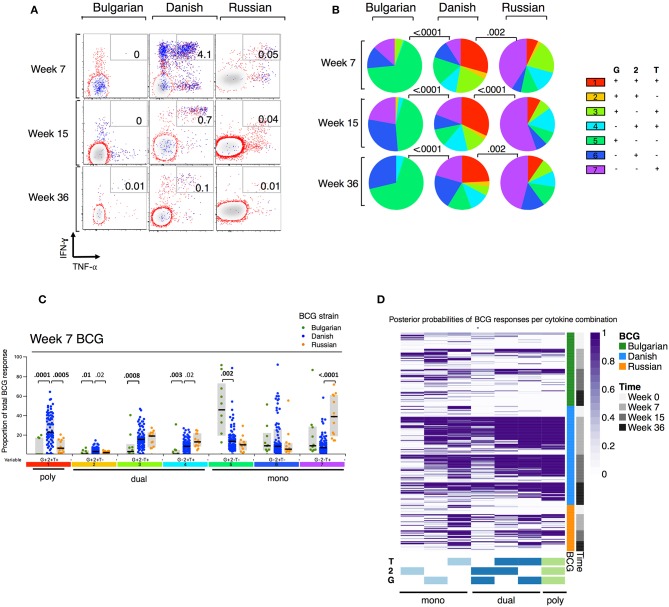
Polyfunction of mycobacterial-specific CD4+ T cell cytokine responses differ between strains. (A) Representative flow cytometry plots showing mycobacterial-specific cytokine expression by CD4+ cells stratified by BCG immunizing strain. Axes show IFN-γ vs. TNF-α expression with IL-2+ cells overlaid and represented by blue dots. Numbers indicate frequency of polyfunctional cells as a percentage of total CD4. (B) Pie charts show median proportions of cytokine combinations (G = IFN-γ, 2 = IL-2, T = TNF-α) as a fraction of the total response among antigen responders in each BCG strain group by SPICE analysis. Pie charts are compared using the SPICE permutations test with P < 0.05 considered significant. (C) Week 7 mycobacterial-specific cytokine profile by BCG immunizing strain. Jitter points show the median proportion of each cytokine combination (G = IFN-γ, 2 = IL-2, T = TNF-α) per infant as a fraction of total cytokine+ cells in infants who were responding to BCG and are color-coded by BCG immunizing strain. Shaded bars show interquartile ranges with line showing median. A Wilcoxon Rank Sum Test was used to compare cytokine combinations by strain with P < 0.01 considered significant after multiple comparison correction. (D) Heatmap of posterior probabilities of mycobacterial-specific responses estimated by COMPASS analysis. Rows represent individual infants and grouped by BCG immunizing strain and time post BCG vaccination (color-coded annotations are shown on right-hand side of heat map). Columns represent cytokine subsets (combinations) ordered by degree of functionality (single to polyfunctional; right to left). The color of each cell corresponds to the probability (range 0–1) of a mycobacterial-specific response for a particular cytokine cell subset per infant, with 1 indicating an antigen-specific response and white indicating background.